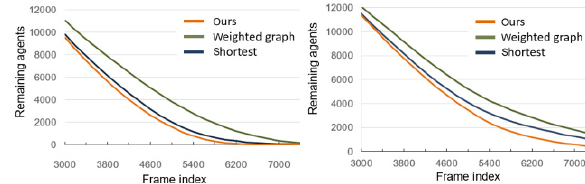
Fig. 13 Island example, numbers of remaining agents over time. Left: normal exit widths. Right: reduced widths of bottom and lower right